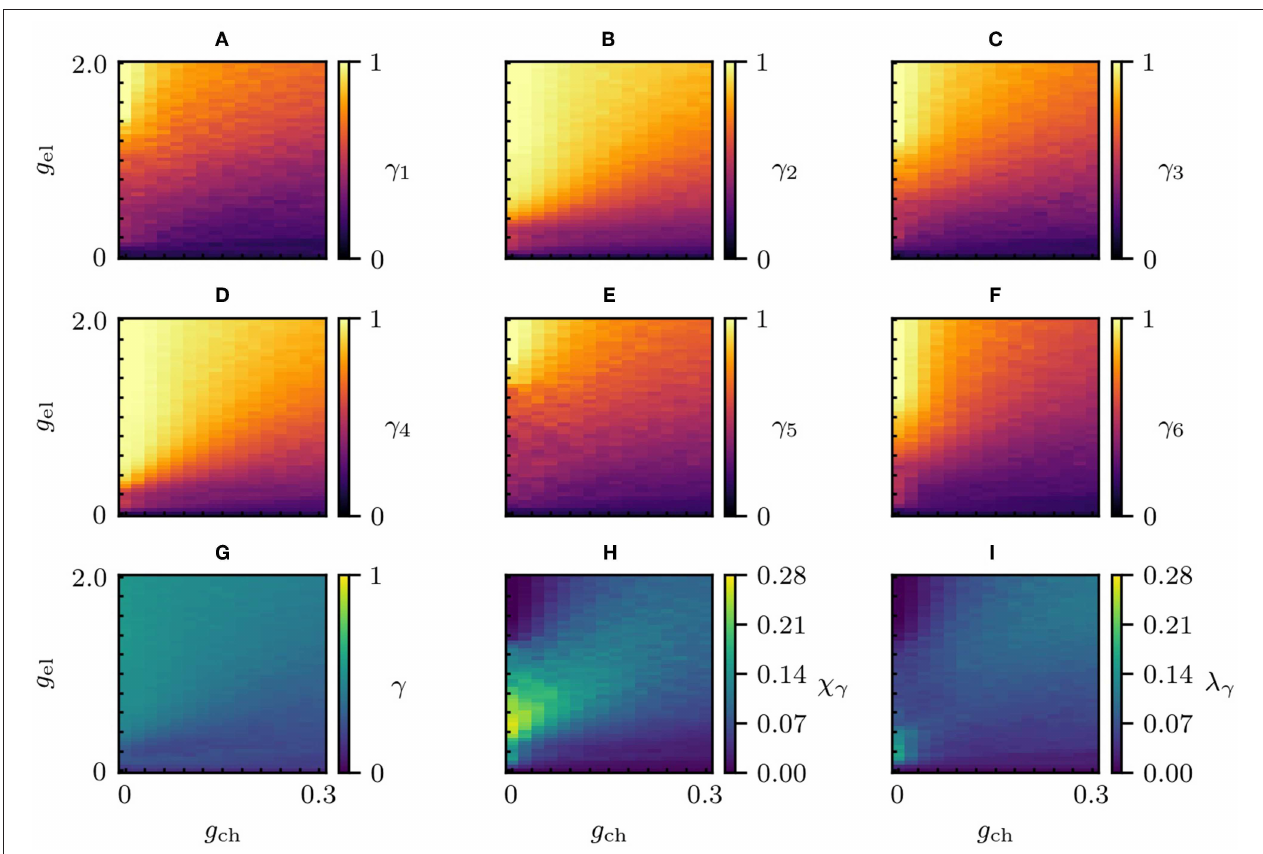
FIGURE 3 | Synchronization parameter scans of the designed network. Changes in the community dynamical properties and global dynamical properties as the electric and chemical coupling strengths vary. (A–F) Level of synchronization of each community, γ 1 to γ 6 . (G) The global level of synchronization γ of the whole network. (H) The chimera-like index χ γ . (I) The metastability index λ γ . System parameters: a = 1, b = 3, c = 1, d = 5, s = 4, p 0 = − 1.6, I ext = 3.25, r = 0.005, V syn = 2 and g wl =